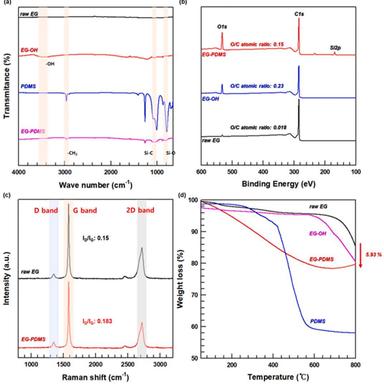
(a) FT-IR spectra, (b) XPS wide spectra, (c) Raman shift, and (d) TGA curves using PDMS grafting process.